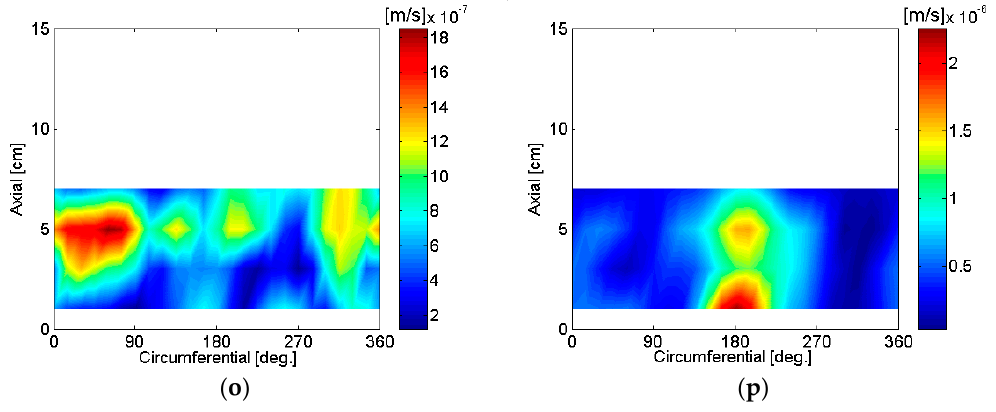
Figure 7. Reconstructed particle velocity of a motor supported on an aluminum base: ( a ) 84 Hz; ( b )